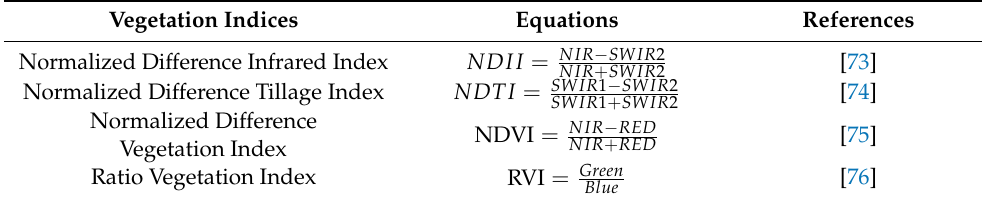
Table 1. VIs introduced into WCM for FL AGL retrieval.